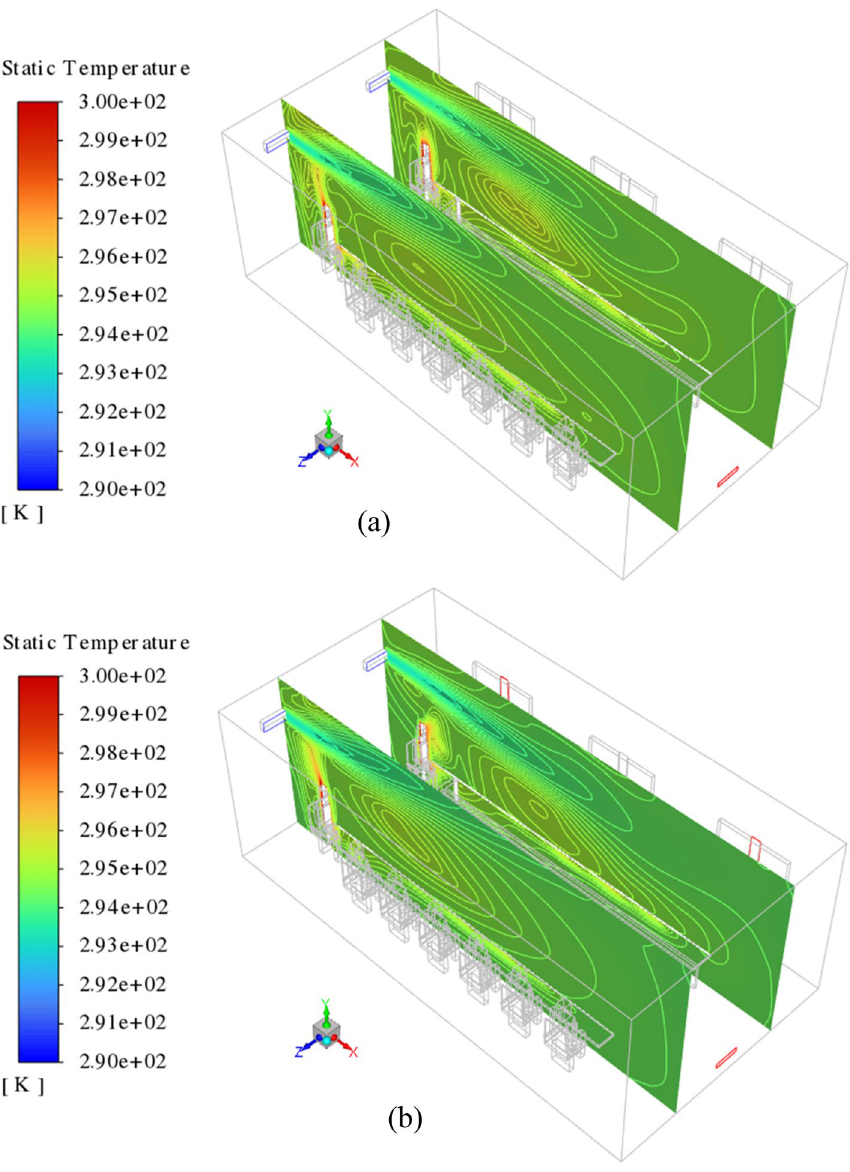
Figure 7. Temperature contour of indoor airflow at z = 2.3 and 4.7 m on the isometric view, for ( a ) all the windows, be closed, and ( b ) windows 1 and 3 be